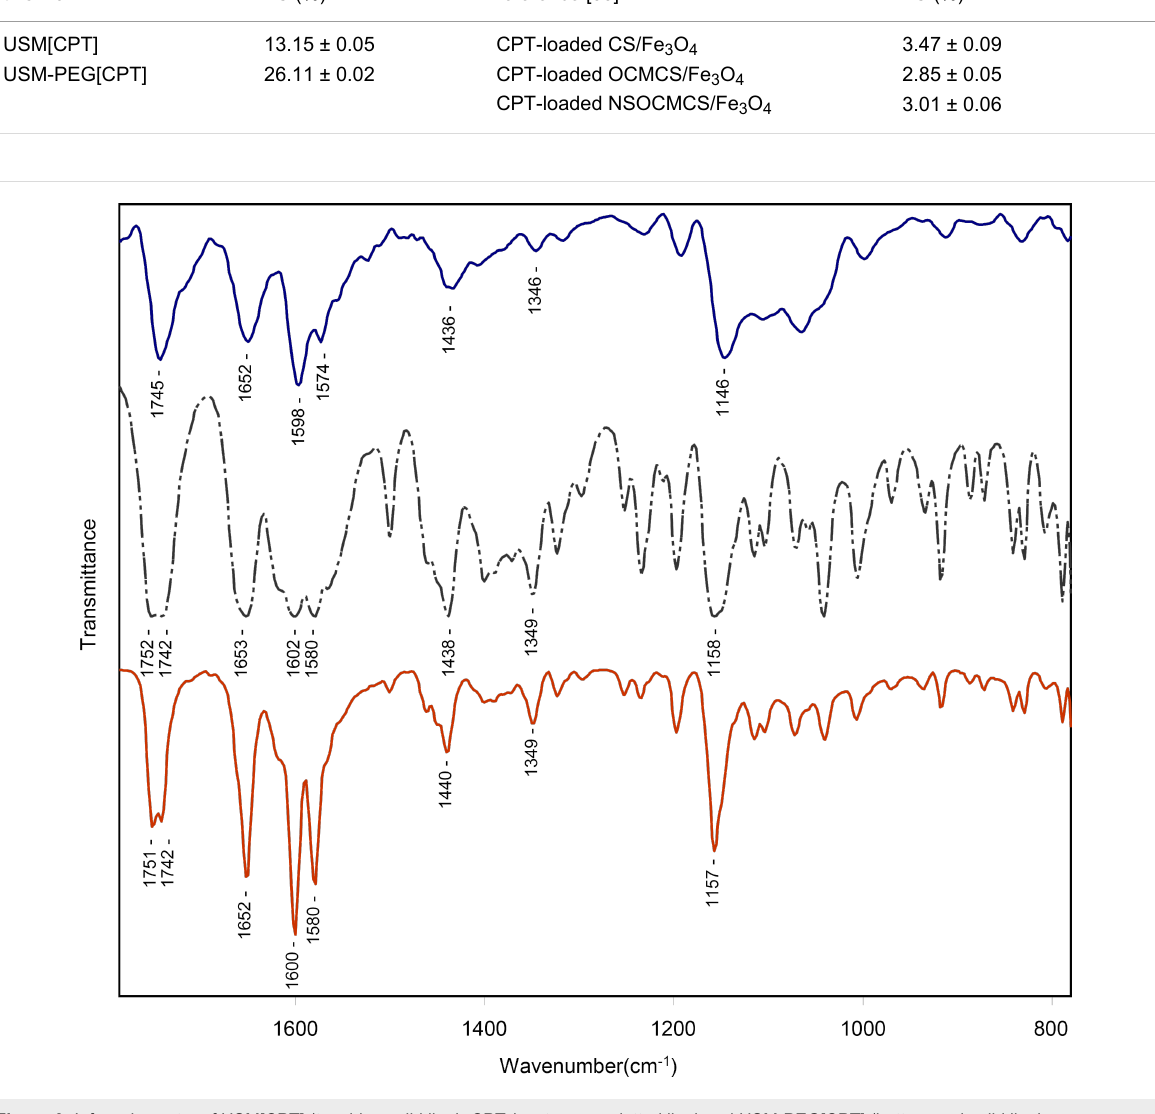
Figure 6: Infrared spectra of USM[CPT] (top, blue solid line), CPT (center, grey dotted line) and USM-PEG[CPT] (bottom, red solid